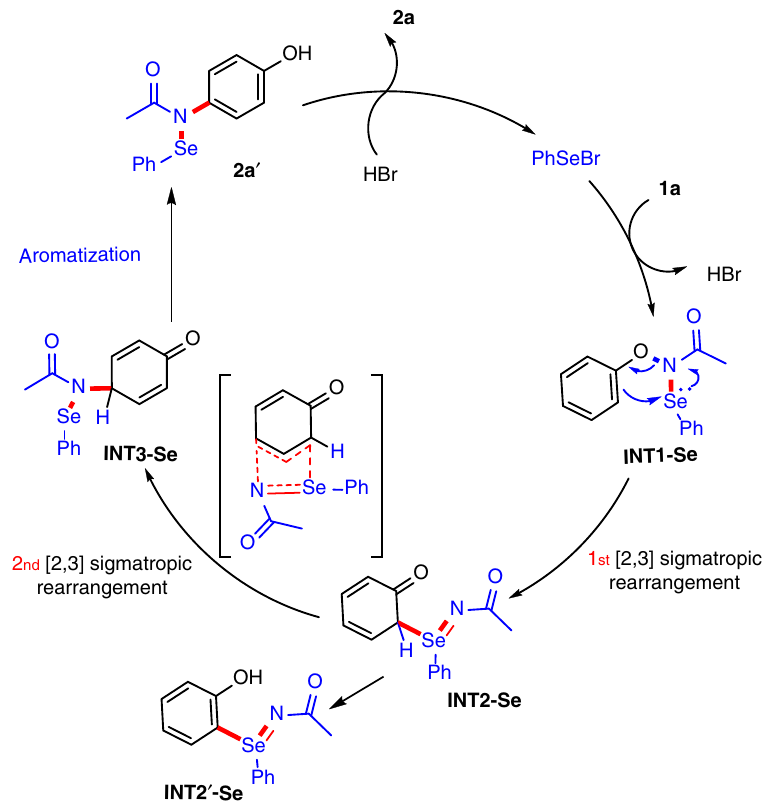
Fig. 2 Proposed catalytic cycle of the organoselenium-catalysed para -amination of phenols. A plausible mechanism illustrating how 2a is formed via two consecutive [2,3]-sigmatropic